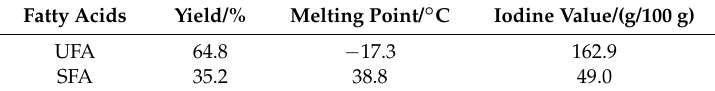
Table 3. Melting point and iodine value of the fatty acids.